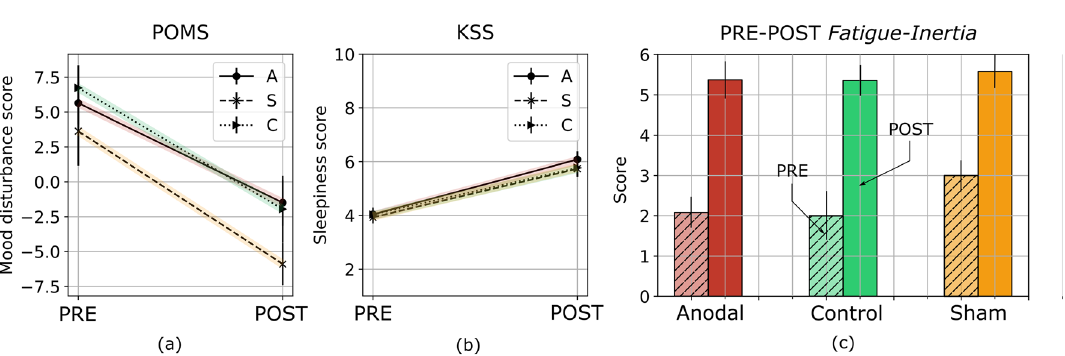
Figure 4. Perceived effort, fatigue, and discomfort scores as a function of time. The shaded segments represent consecutive time points where a statistically significant effect of time was found; the asterisk presents time points (phase) where a significant effect of condition was evidenced.